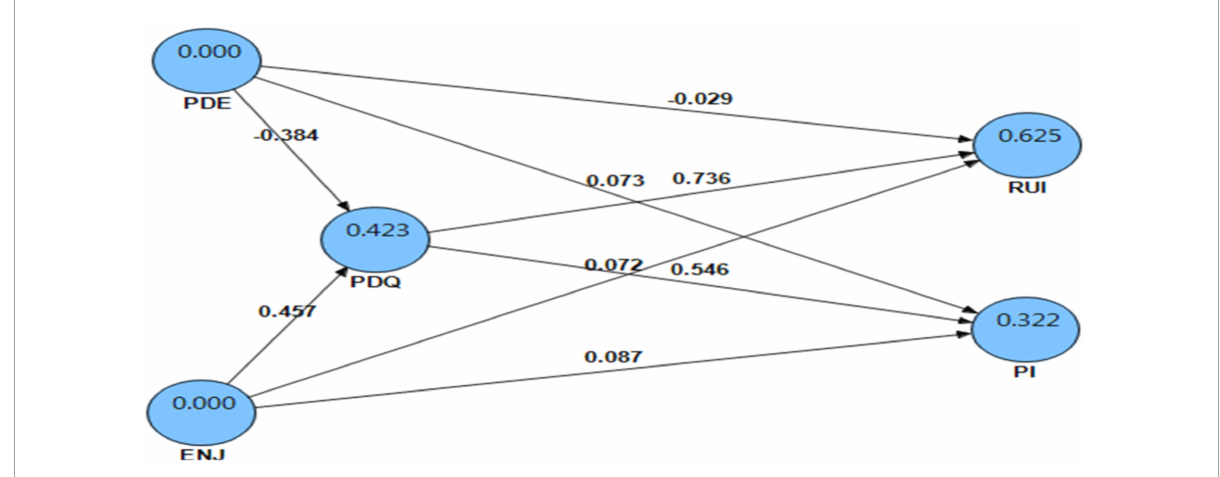
FIGURE3 Partial lease square